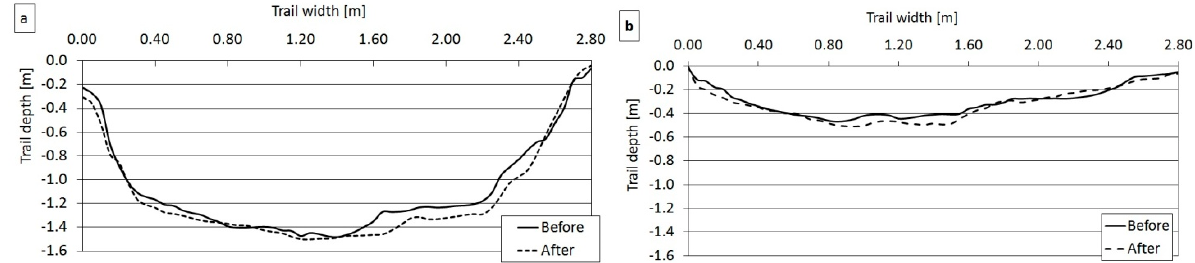
Figure 8. Topography on the trail sections before and after skidding: ( a ) Tt129U and ( b ) Tt129L.